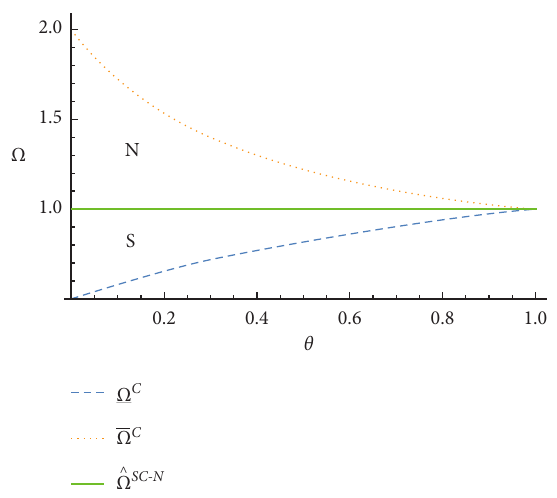
Figure 4: Performance of whole supply chain.